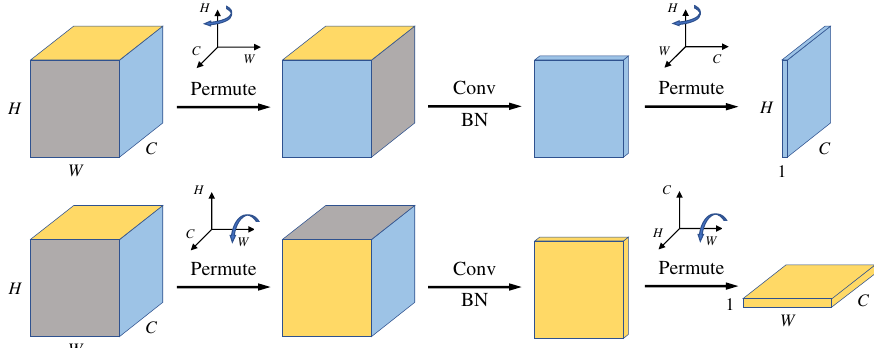
Figure 4. The attention-map-generation process of SCA. The top branch represents the cross- dimensional interaction between C and H , and the bottom branch represents the cross-dimensional interaction between C and W